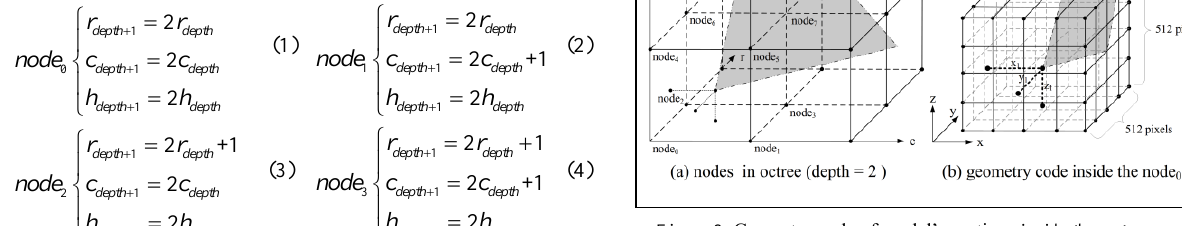
Figure 3. Geometry code of model’s vertices inside the octree